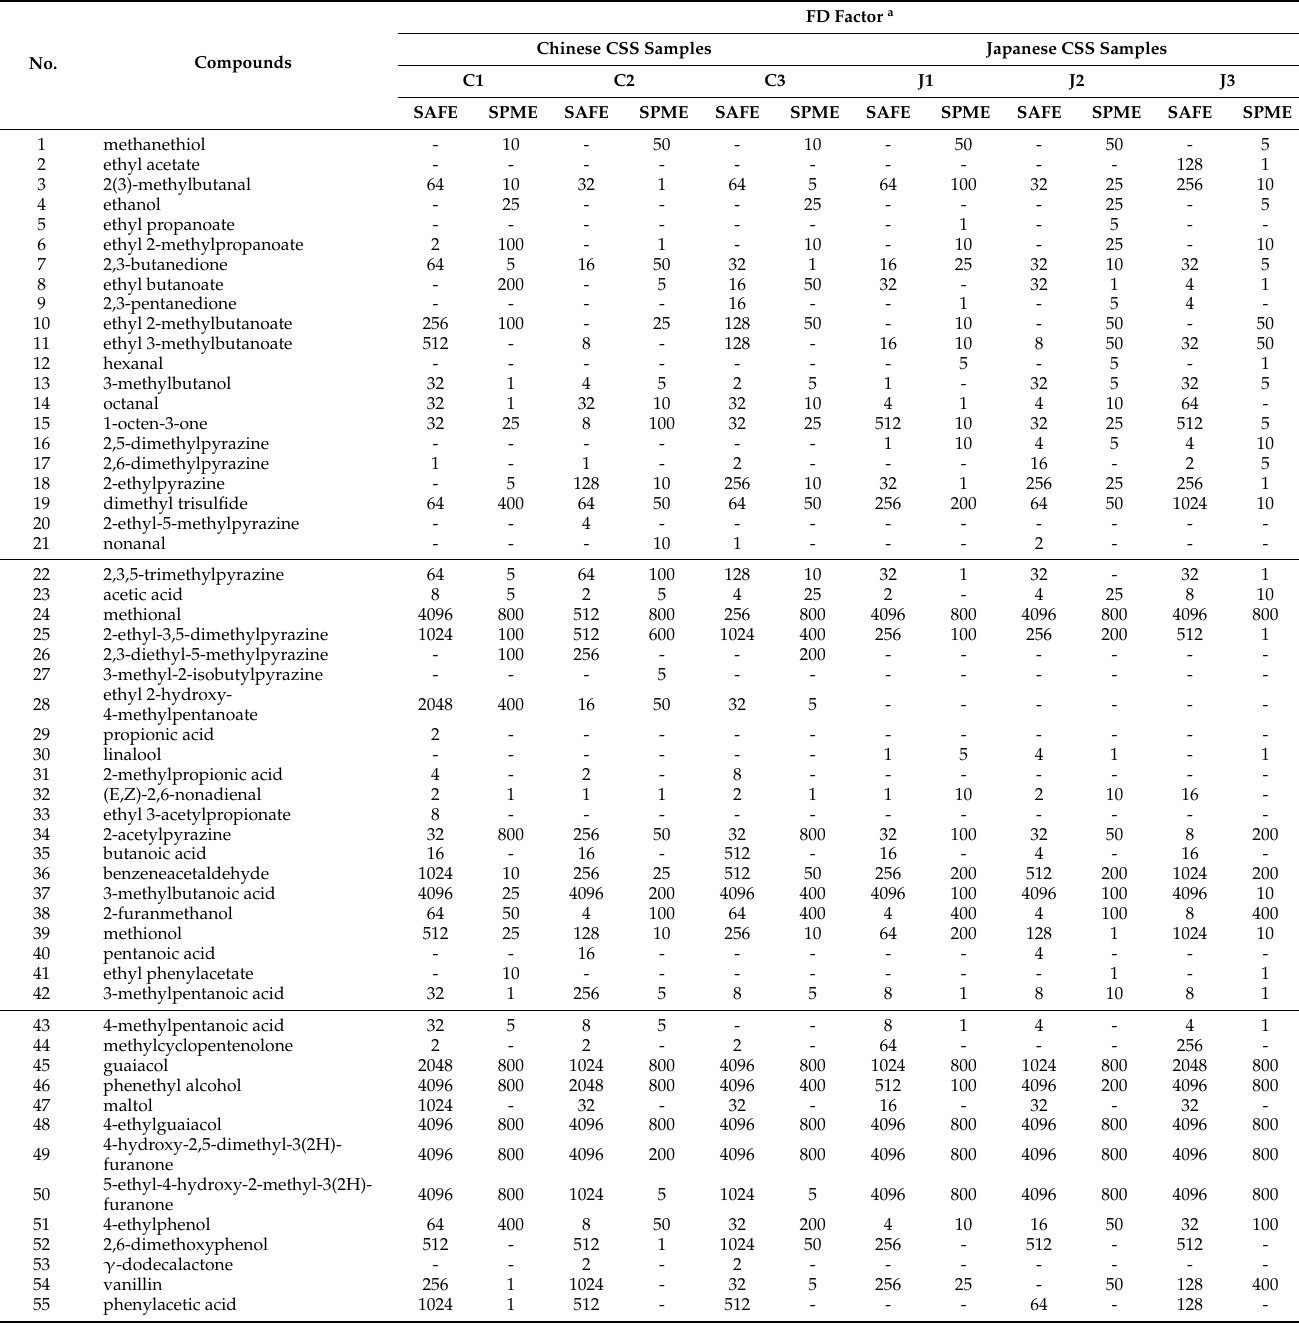
Table 2. FD factors of odor-active compounds in six CSS